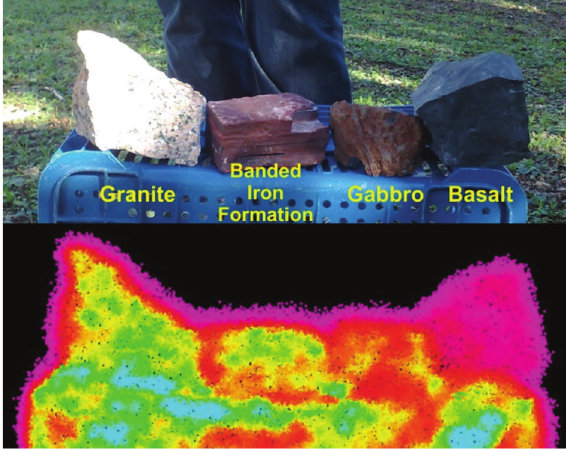
Figure 6: Initial survey with rock samples, 60 meters apart from the scanner. The unusual magenta points around the samples are the edge effect.